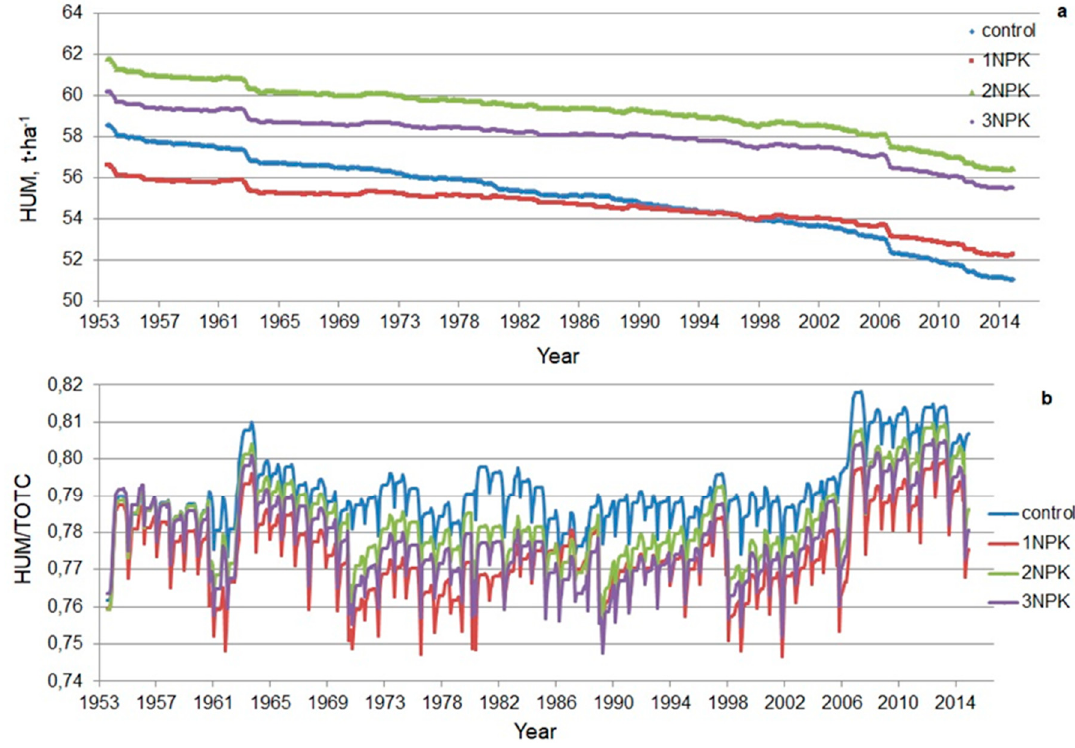
Figure 6. The dynamics of humified organic matter carbon HUM pool ( a ) and the proportion of humified C to its total soil stock ( b ), calculated using the RothC model with monthly data.